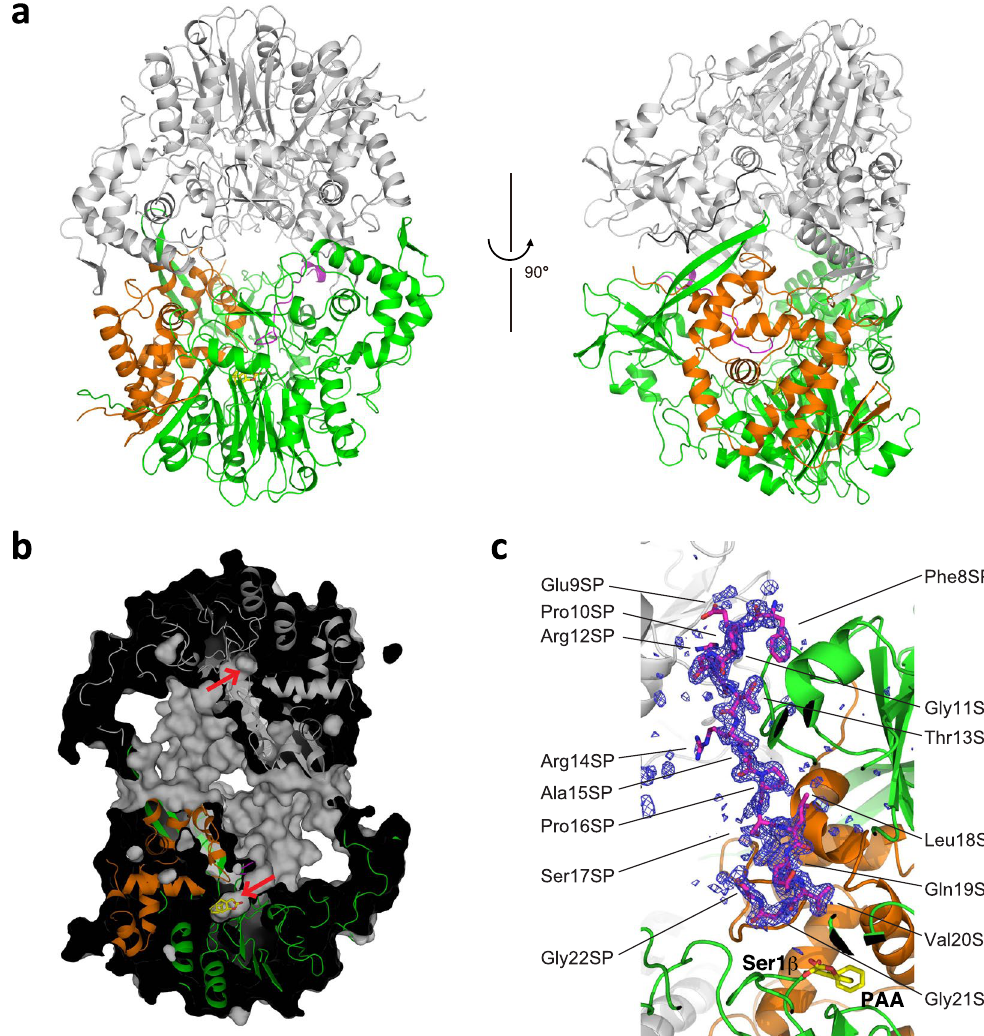
Figure 3. Capsule-shaped assembly of MacQ. ( a ) Ribbon diagram of molecular structure of MacQ formed face-to-face by two heterodimers shown in Fig. 2b. One heterodimer is shown as the same colour scheme to that in Fig. 2b, and the other heterodimer is shown in gray. Two perpendicular views are shown. ( b ) Cross section of the molecule in surface representation showing the interior space of the capsule-like molecule of MacQ and the substrate-binding pocket indicated by the red arrow. The bound PAA is also shown as a yellow stick model. ( c ) m Fo- D Fc omit map for the observed SP region contoured at 2.6 σ level. The final refined model of the SP is shown as stick model and the residues are labelled. The bound PAA and the Ser1 β are also shown in stick model. As shown here, the model for the residues Gly1SP-Ala7SP and Glu23SP-Gly27SP are not built due to the poor electron